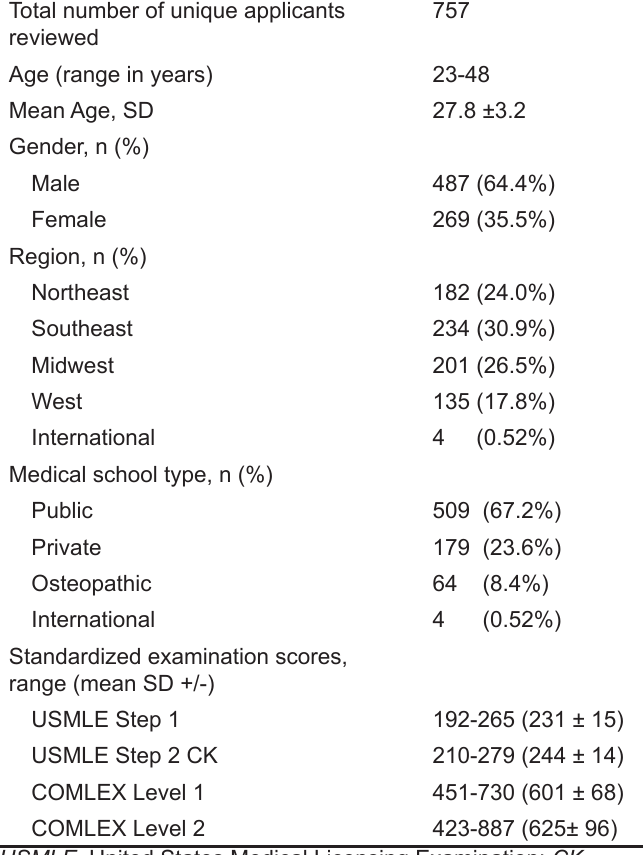
Table 2. Demographic characteristics of the applicants. Table 3. Descriptive statistics correlating final Likert scale “likelihood